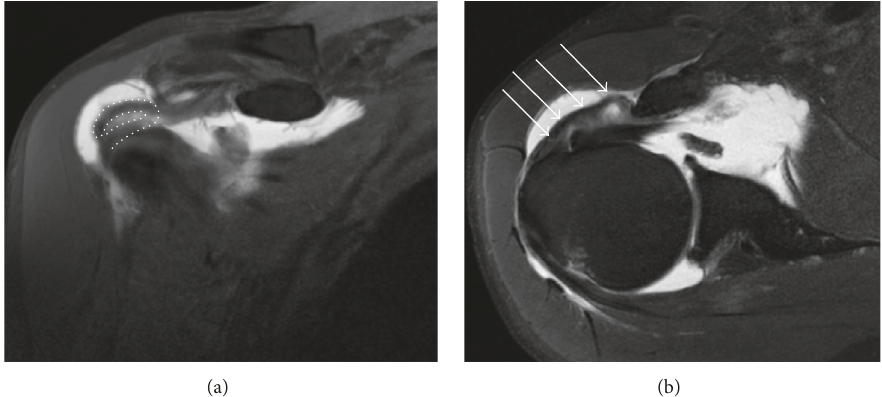
Figure 2: Coronal T1-weighted (a) and axial T2-weighted (b) with fat saturation of a right shoulder. The supraspinatus flopped on itself (white dotted line) and healed on the anterior humerus (white